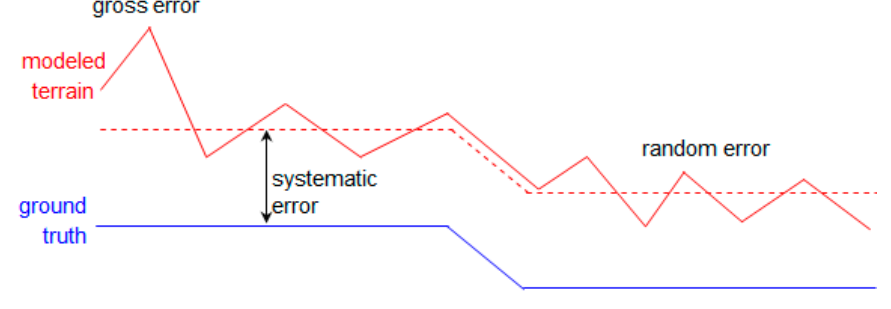
Figure 4. Main behaviours of DEM error.